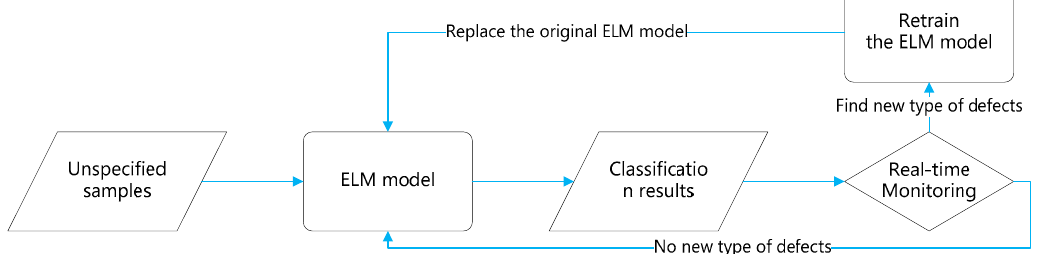
Figure 11. Flowchart of the online monitoring system.